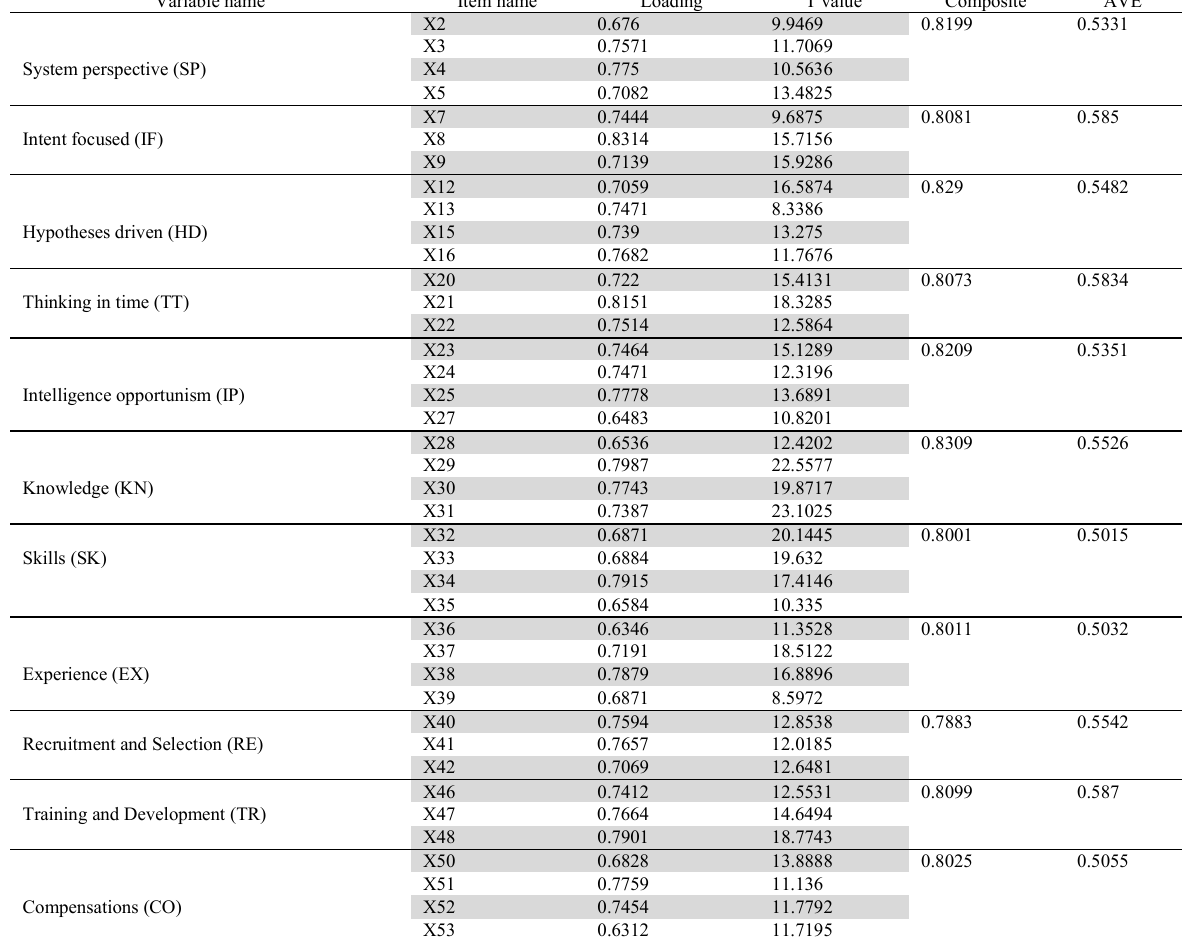
The measurement model reliability and convergent